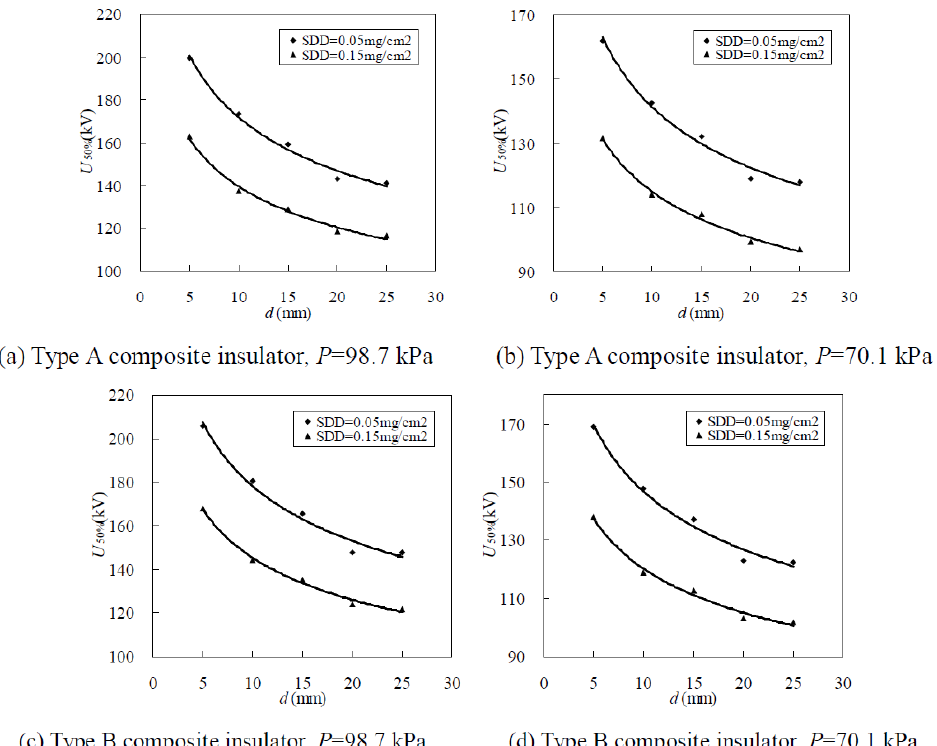
Figure 7. Relationship of U and d of composite insulators covered with ice ( N = 50%